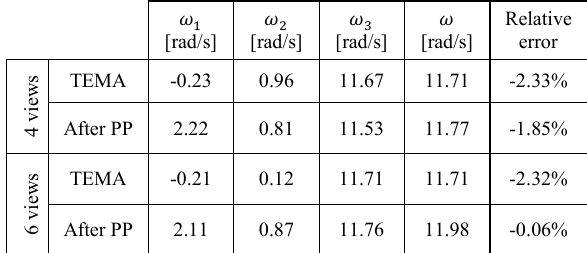
Figure 9. Objects used in the experiments: (a) brick, (b) fragment, and (c) artificial rock sphere. Red arrows indicate axis of rotation.